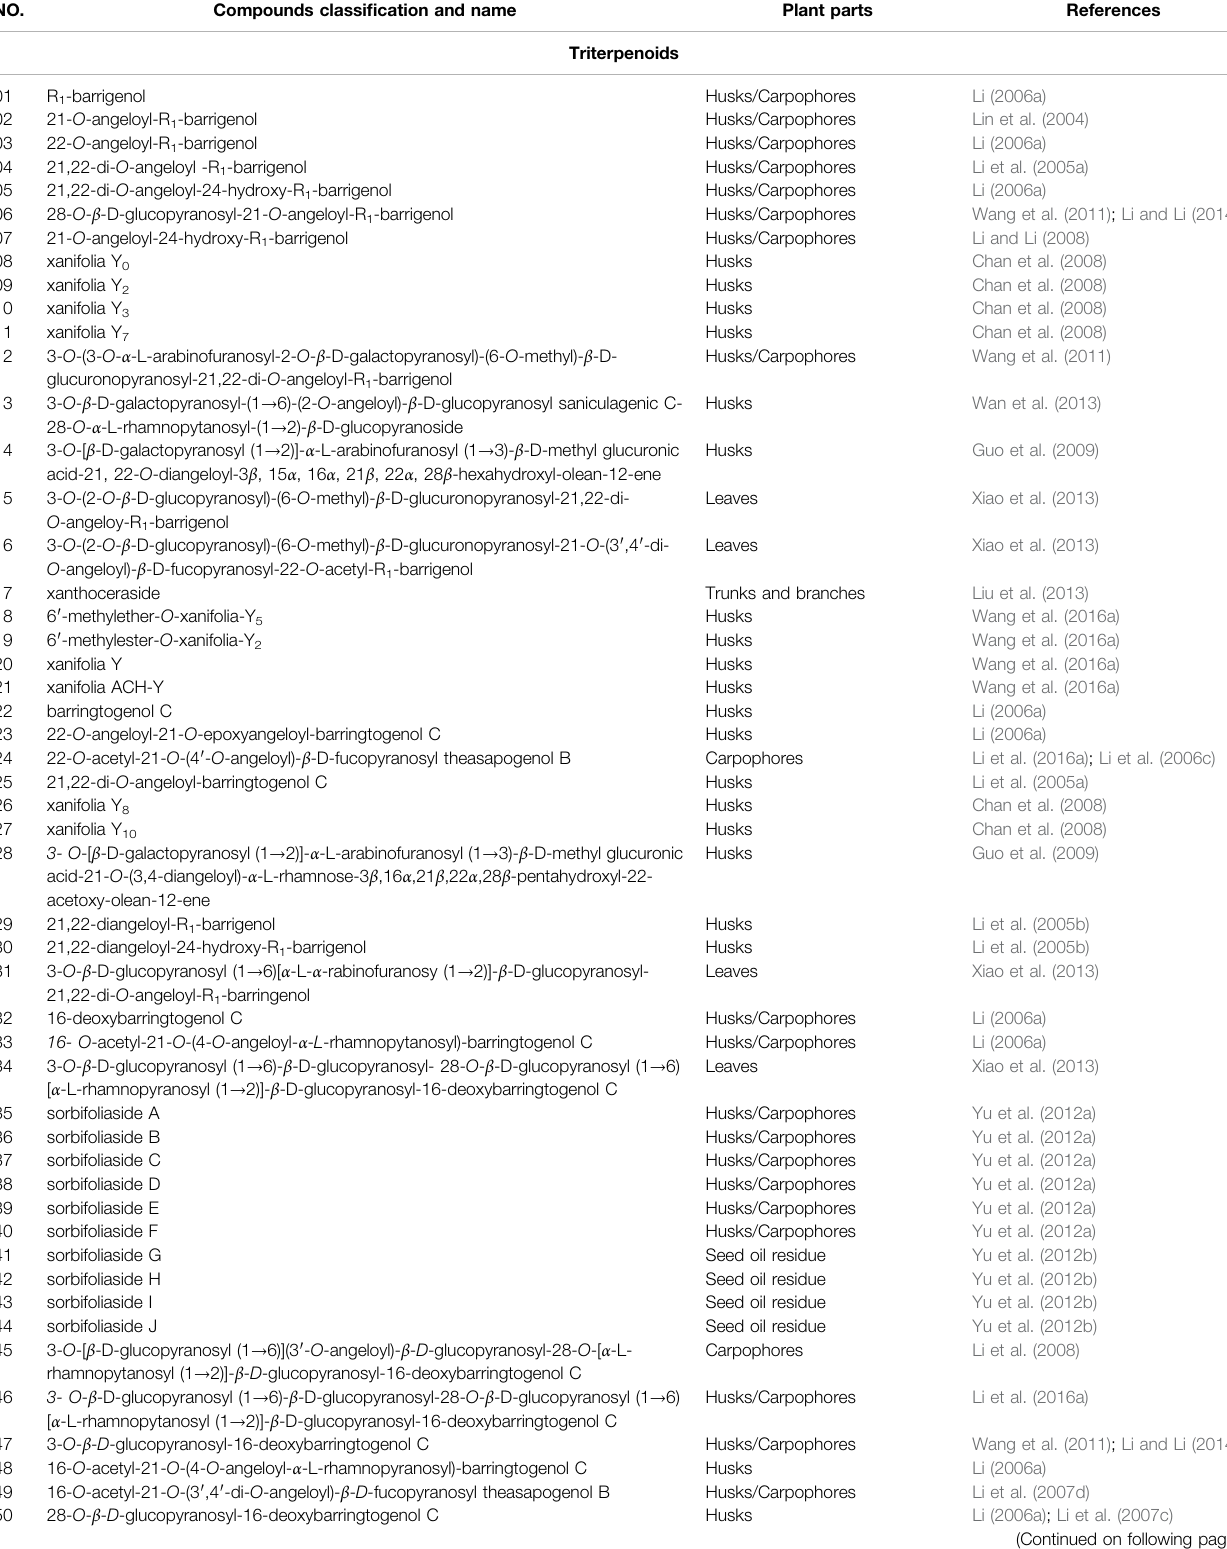
TABLE 1 | The compounds isolated from X.